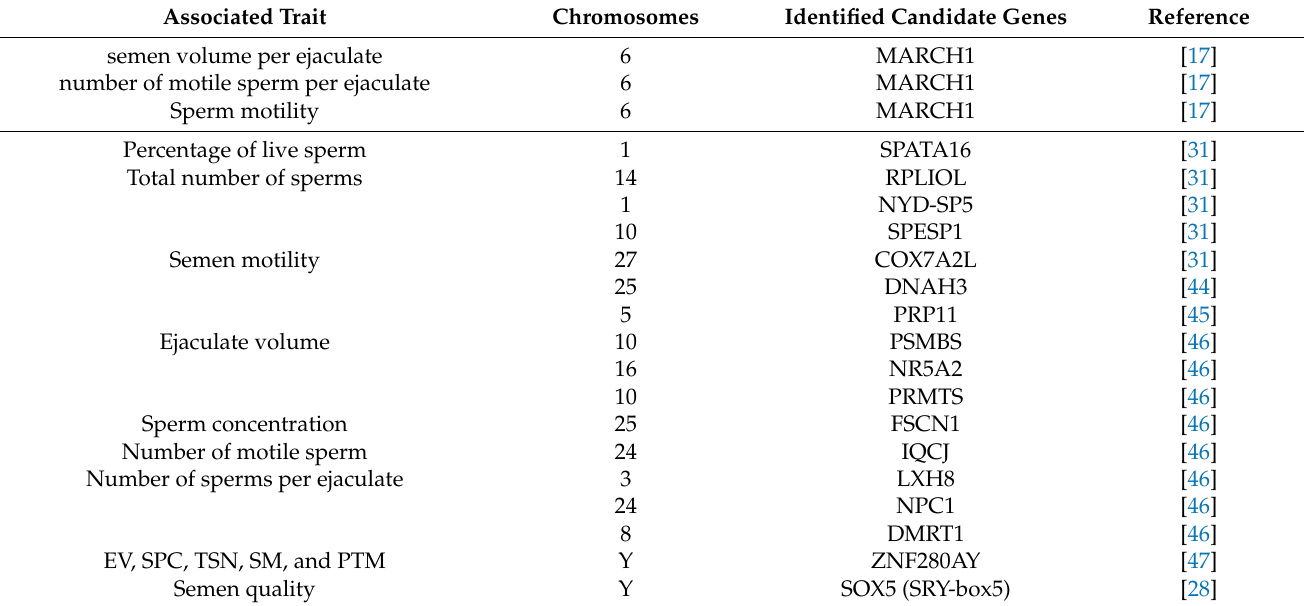
Table 3. Genes associated with different semen